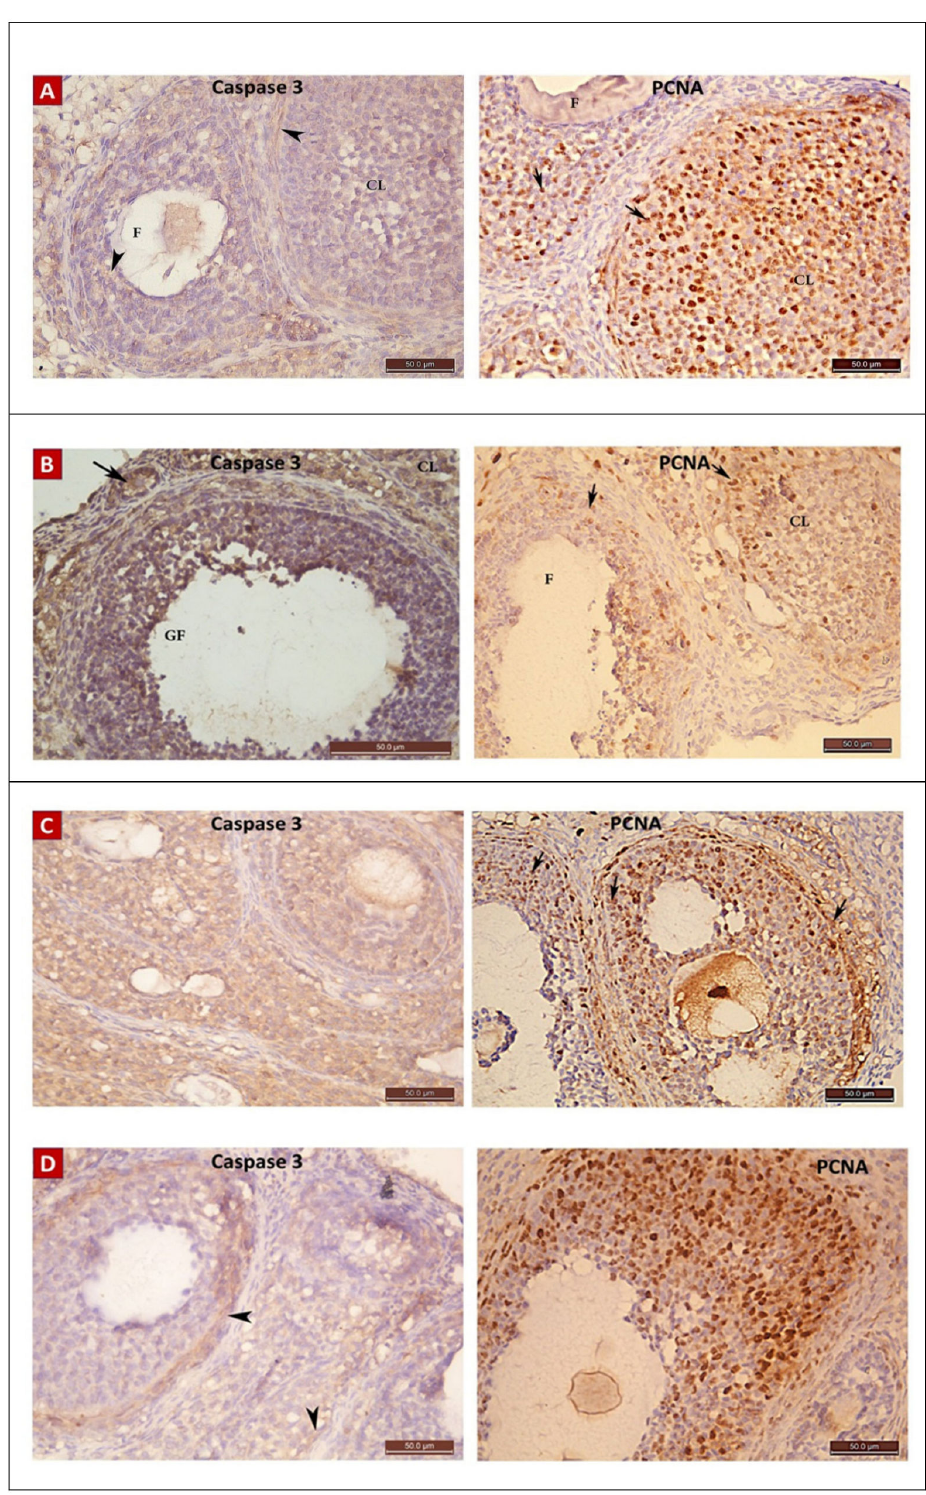
Figure 10. Anti-caspase 3 and anti-PCNA immunostaining × 400 photomicrographs in ovaries of all study groups. Immunostained ovarian sections from control (G I) ( A ), POI (G II) ( B ), diosmin 50 (G III) ( C ), and diosmin 100 (G IV) ( D ) groups. Anti-caspase 3 immunostaining appears as deep brown cytoplasmic reaction in B ovary, while little reaction is apparent in A, C, and D. The anti-PCNA reaction showed many positive brown nuclear reactions in A, C, and D with lesser number in